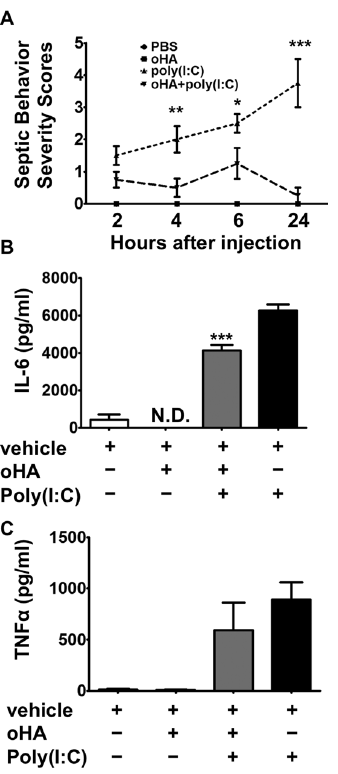
Figure 1. Oligo-HA protects mice from poly(I:C) induced shock response and inhibits cytokine release. Mice were injected i.p. with vehicle (PBS), oligo-HA (100 m g/mouse), oligo-HA and poly(I:C) (100 m g/mouse), or poly(I:C) alone. (A) Septic behavior severity scales were scored as described in Materials and Methods. Serum IL-6 (B) or TNF a (C) was measured 6 h after injection by ELISA. Data are means 6 S.E.M. and are representative of three independent experiments with n=4 per group. *: p , 0.05, **: p , 0.01, ***: p , 0.001, N.D.: not